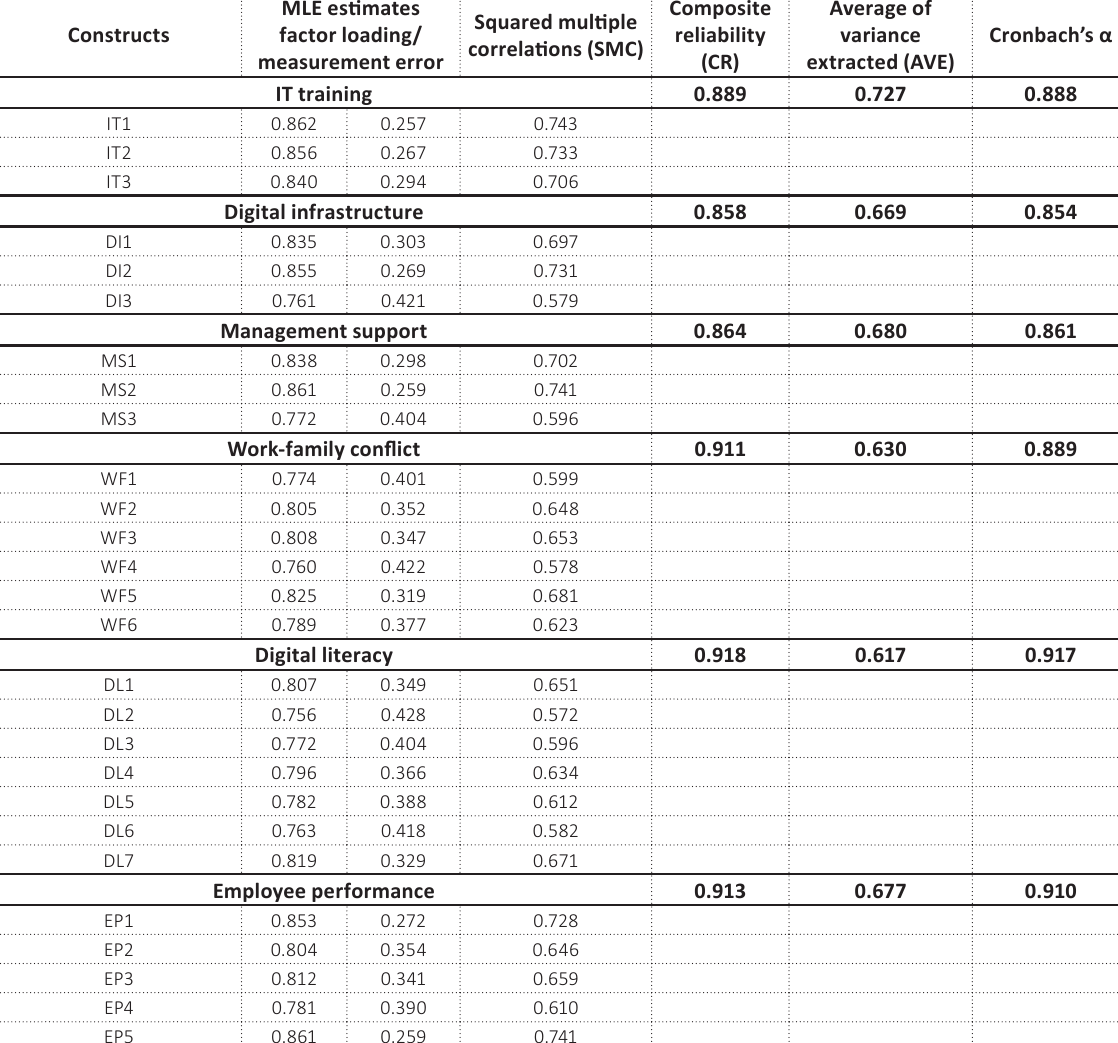
Table 3. Measurement results Constructs